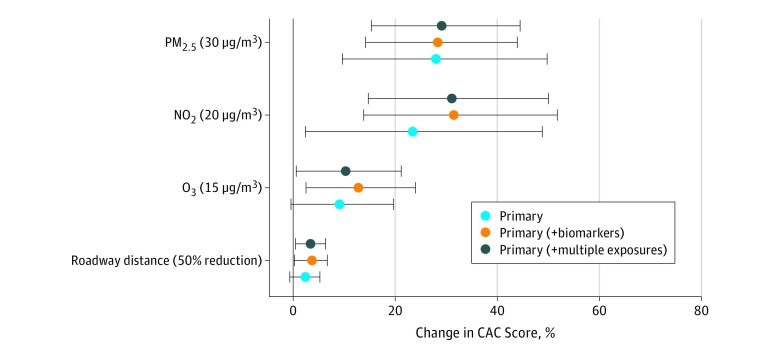
Coronary Artery Calcium (CAC) Score Associated With an Increase in Long-term Air Pollutant ExposurePercentage increase in CAC scores with 95% CIs (error bars). The interquartile range increases in pollutants are 30 μg/m3 for particulate matter with aerodynamic diameter less than 2.5 μm (PM2.5), 20 μg/m3 for nitrogen dioxide (NO2), and 15 μg/m3 for ozone (O3); there was a 50% decrease for distance from a roadway. The primary model included age, sex, body mass index, smoking status, smoking years, cigarettes per day, alcohol consumption, education, exercise, urbanization, regions, distance to hospital, and Beijing residence (yes or no). The primary model plus biomarkers also included levels of total cholesterol, high-density lipoprotein cholesterol, low-density lipoprotein cholesterol, triglycerides, and high-sensitivity C-reactive protein. The primary model plus multiple exposures also included PM2.5, NO2, O3, and distance to road variables.